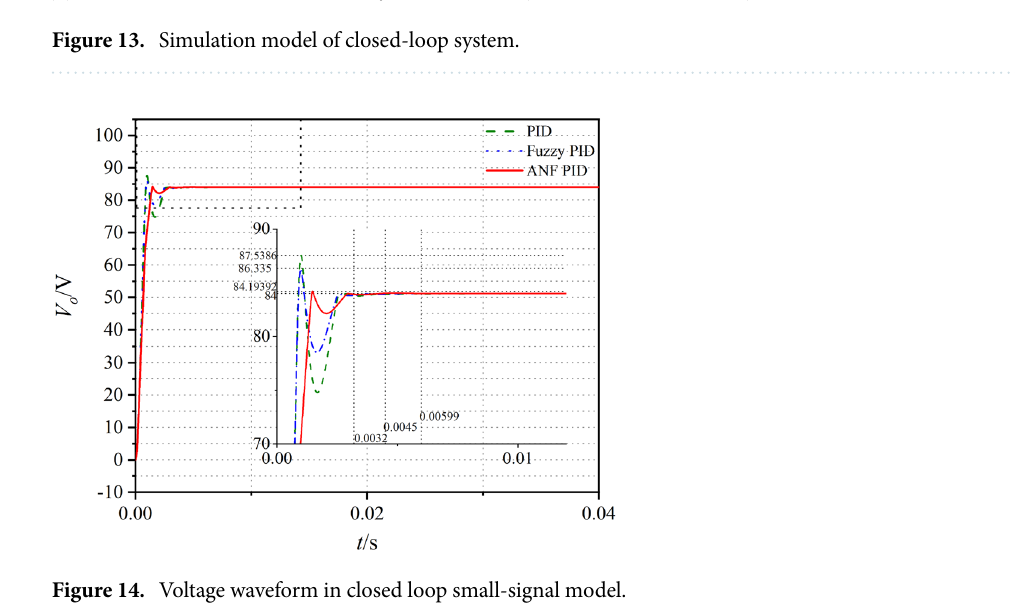
Figure 14. Voltage waveform in closed loop small-signal